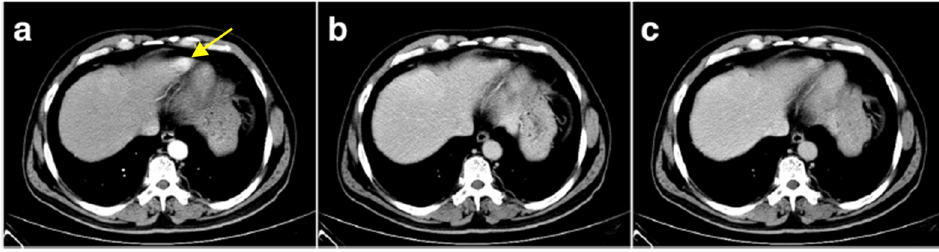
Figure 6. Contrast enhanced liver CT. ( a – c ): Arterial, portal, and equilibrium phase, respectively (reprinted from [55] under the license CC BY 4.0). Yellow arrow: left liver apex mass which re-enhanced contrast during the arterial phase.